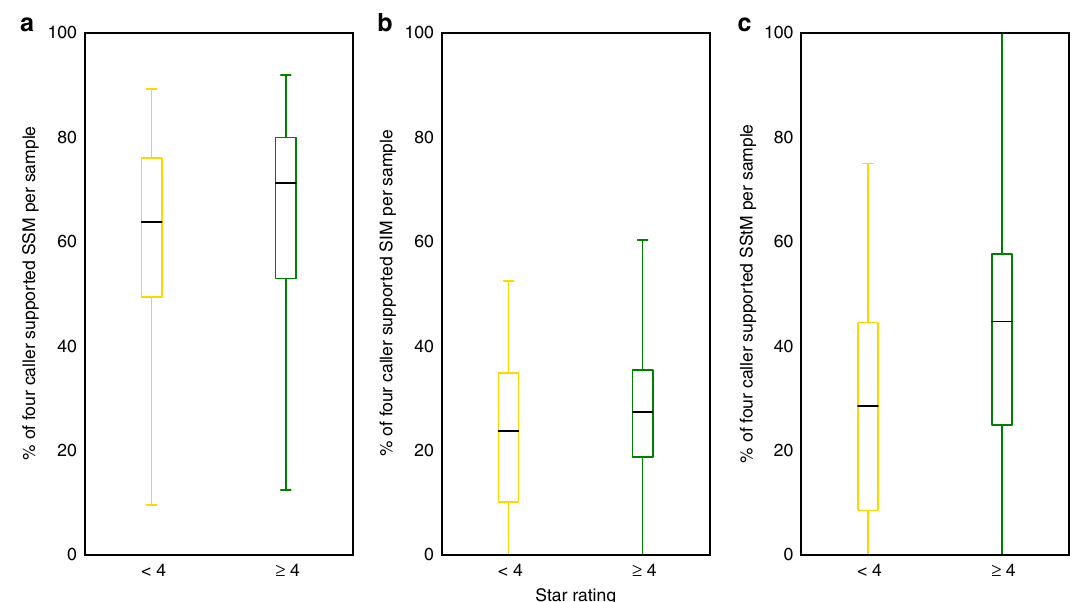
Fig. 4 Quality of sequencing in samples is linked to consensus in somatic mutation callers. Box plots comparing percentage of different types of somatic mutations supported by four callers for each sample, with median, the 25% and 75% quartiles shown by the box and the whiskers illustrating 1.5× the interquartile range. Samples with four stars or more tend to have a higher proportion of a SSM ( n = 2777 samples), b SIM ( n = 2777 samples), and c SStM ( n = 2712 samples) supported by four callers than samples with fewer than four stars. These are all signi fi cant using a two-sided Mann – Whitney U test, with adjusted p -values a 3.94 × 10 − 4 , b 4.86 × 10 − 4 and c 1.16 × 10 − 17 (adjusted using the Bonferroni correction, also see Supplementary Table